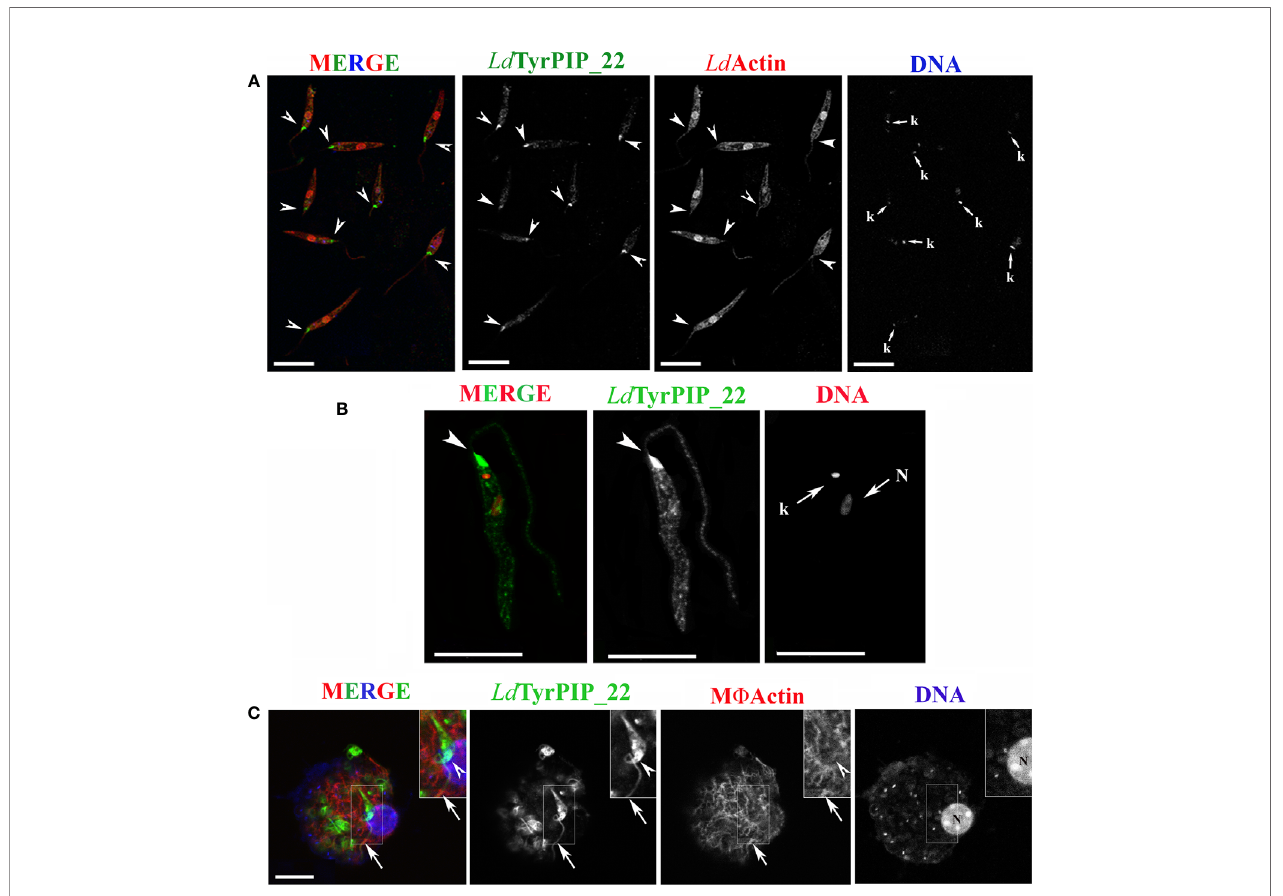
FIGURE 6 | Localization of Ld TyrPIP_22 epitopes in axenic L. donovani promastigotes after 24 h exposure at 37°C and pH 5.5 or during a 4 h in vitro infection of J744 macrophages. (A, B) Confocal microscopy images of L. donovani stationary phase promastigotes incubated for 24 h at 37°C and pH 5.5. Images were acquired with a Leica SP8 confocal microscope by z-scanning with 0.3 m m step size. Images in (A) were acquired at 1X digital magni fi cation while in B at 4X. (A) Double IF staining of fi xed cells permeabilized with 0.1% (v/v) Τ riton X-100 was performed with the a- Ld TyrPIP_22 mouse pAb (1:100) and a- Ld Actin rabbit pAb (1:1,000) followed by secondary Abs conjugated to Alexa Fluor ® 488 or Alexa Fluor ® 546. Nuclear and kinetoplast DNA was stained with Hoechst 33342 (1:5,000). Images (max projections) of several promastigotes are presented. In the DNA stain the kinetoplast (small arrow, k) is more intensely stained than the nucleus. (B) An image of a promastigote (single z section of a z-series) acquired with a 4X magni fi cation factor. IF staining for Ld TyrPIP_22 and DNA staining were performed as in (A) . The nuclear (N) and kinetoplast (k) DNA staining is presented here in red pseudo color for better contrast in merged image. (C) A J774 murine macrophage 4 h post-infection in vitro with L. donovani promastigotes imaged by confocal microscopy. Stationary phase promastigotes were added to adhered macrophages at a 20:1 ratio. IF staining of fi xed cells permeabilized with 0.1% (v/v) Τ riton X-100 was performed with the a- Ld TyrPIP_22 mouse pAb (1:100) followed by secondary Ab conjugated to Alexa Fluor ® 488. Macrophage polymerized actin was stained with phalloidine conjugated to Alexa Fluor ® 546. Images were acquired with a Leica TCS SP5 confocal microscope by z-scanning performed at 1 m m step size. A single optical section from the top of the cell is presented. A promastigote, still extracellular in most part but in the process of being phagocytozed is shown in the insets (1.5X magni fi cation). Single FL and phase contrast images are presented in BW while images of the three merged FL signals are shown in color. The molecule highlighted in the BW images with single color FL is indicated at the top in the same color as the respective FL signal. In (A) , (B), and (C) arrowheads point to the fl agellar pocket/base of fl agellum. Small arrows in (A) and (B) point to the kinetoplast (k) and nucleus (N) while large arrows in (C) point to polymerized actin surrounding part of the phagosytozed parasites ’ fl agellum. Scale bar size in (A – C) : 10 m